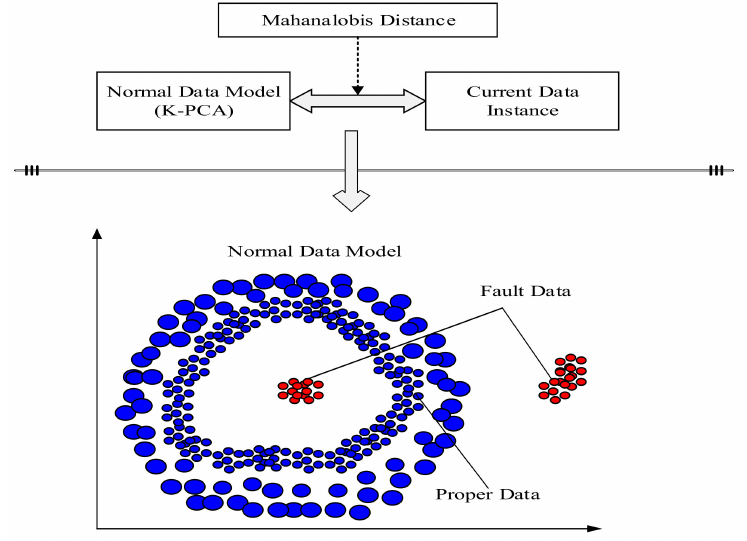
Figure 2. Fault Data Detection by Rapid Kernel Principal Component Analysis